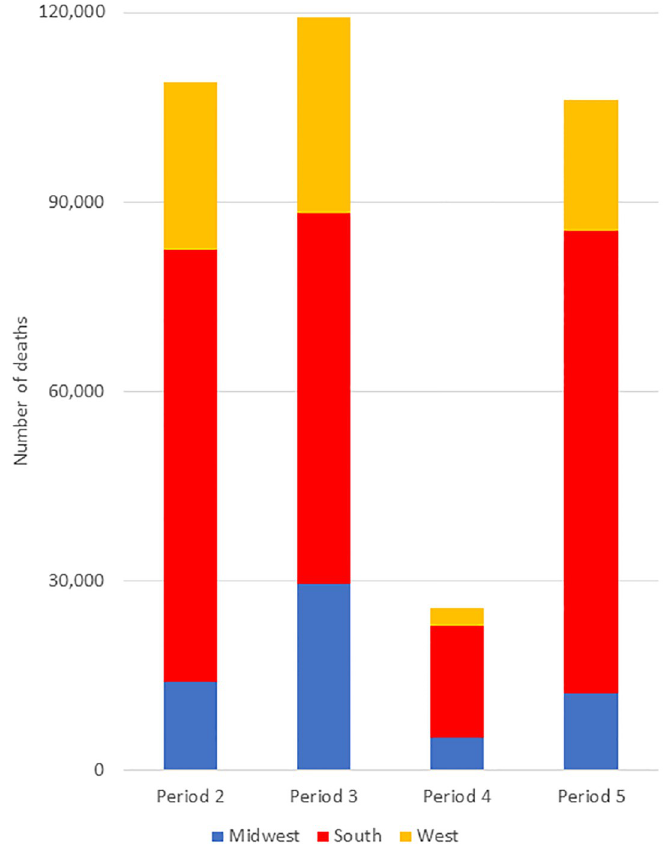
Fig 3. Number of avoidable deaths by period and region, U.S., January 3, 2020—September 26, 2021. The height of each bar represents the total U.S. avoidable deaths in each period and the colored sections represent the number of avoidable deaths in each region during the period. Periods defined as follows: Period 1 (January 3 to May 30, 2020), Period 2 (May 31 –October 3, 2020), Period 3 (October 4, 2020 to February 27, 2021), Period 4 (February 28 to June 26, 2021), and Period 5 (June 27 to September 26, 2021). Source: authors’ calculations based on CDC data.